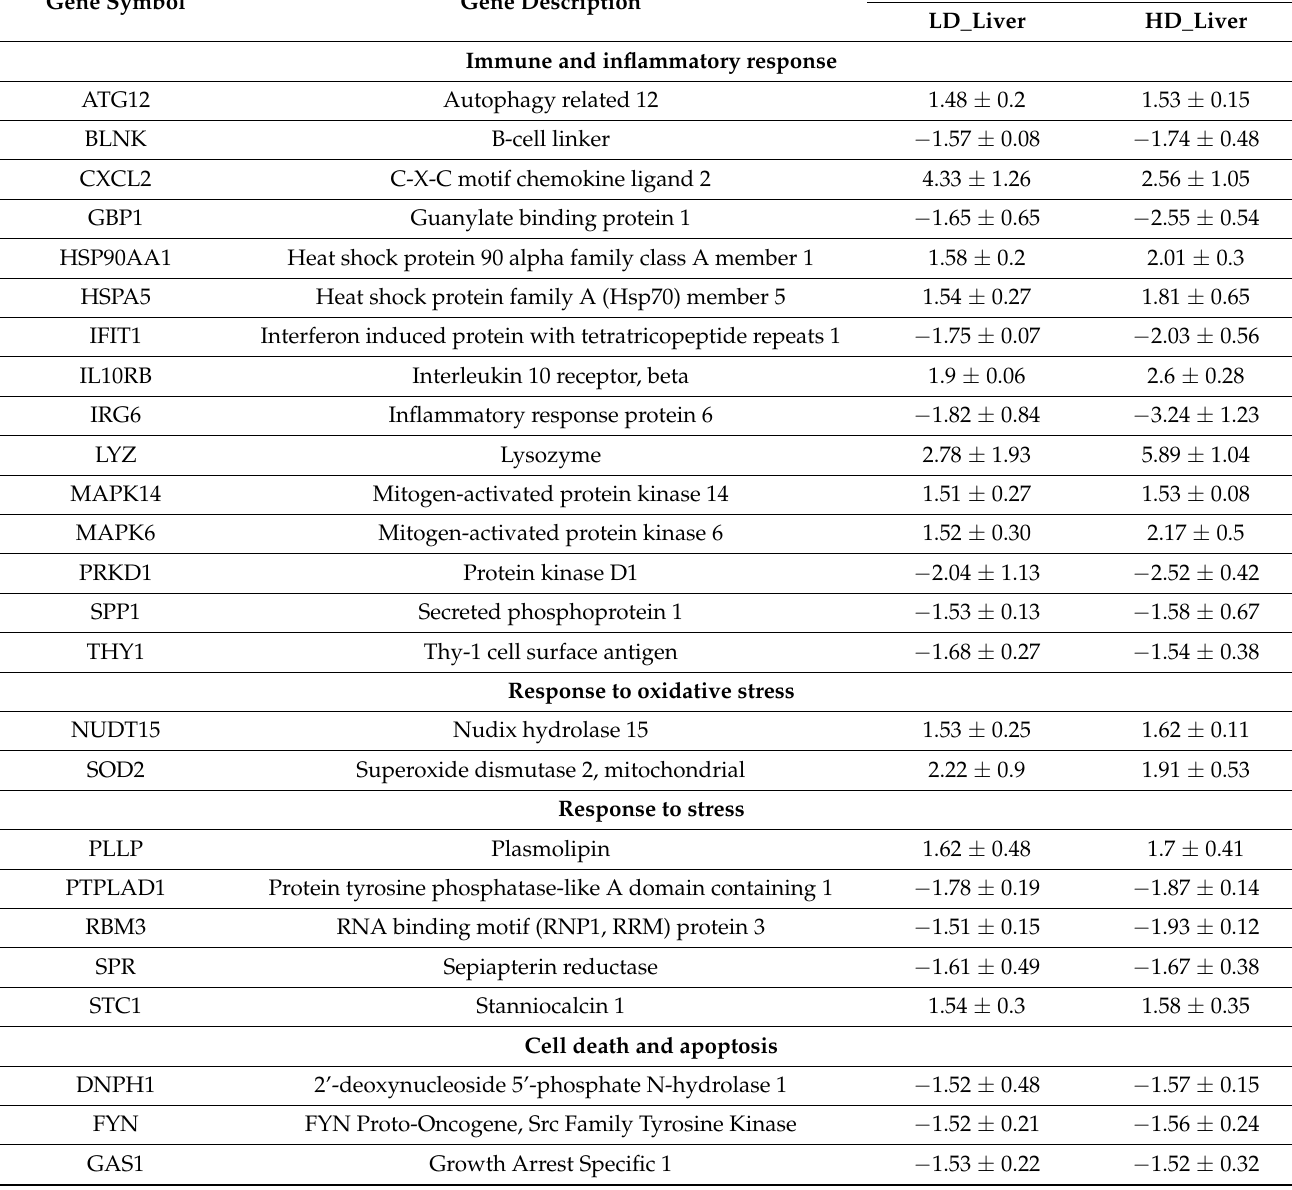
of 70 genes are regulated in common. Panel B : Venn diagram of kidney DEGs and a total of 144 and 286 genes were significantly regulated in low- and high-dose treatments, respectively, of which 66 were commonly regulated. Panel C: Shown is the average linkage hierarchical gene clustering of hepatic DEGs with Euclidean distance as default. The signal intensity values of regulated DEGs are depicted in the heat map. The low- and high-dose treatment groups are clearly separated from the controls. Panel D: Shown is the average linkage hierarchical gene clustering of kidney-related DEGs with Euclidean distance as default. The signal intensity values of regulated DEGs are depicted in the heatmap. The low- and high-dose treatment groups are clearly segregated from the controls. Table 1. Commonly regulated hepatic DEGs after low- and high-dose diclofenac treatment. Minipigs were given 3mg/kg or 15 mg/kg daily for 28 days. Whole genome expression profiling was performed and DEGs were calculated based on the criteria fold change > 1.5 and a p -value < 0.05. Collectively, 70 genes were regulated in common when low- and high-dose treatment groups were